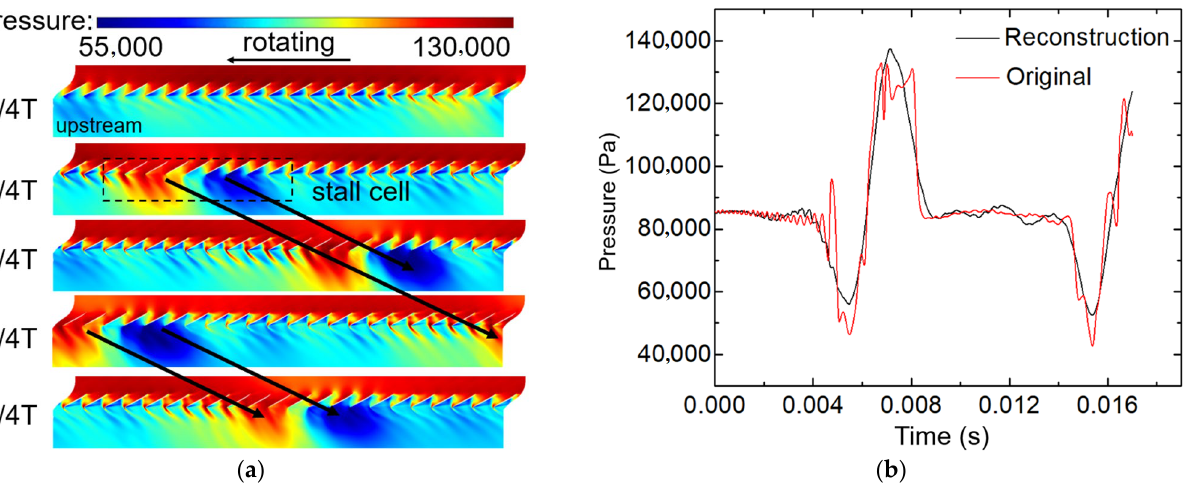
Figure 17. Flow field reconstruction results. ( a ) First 11 modes reconstruction flow. ( b ) Pressure collected by the probe in front of the tip leading edge.